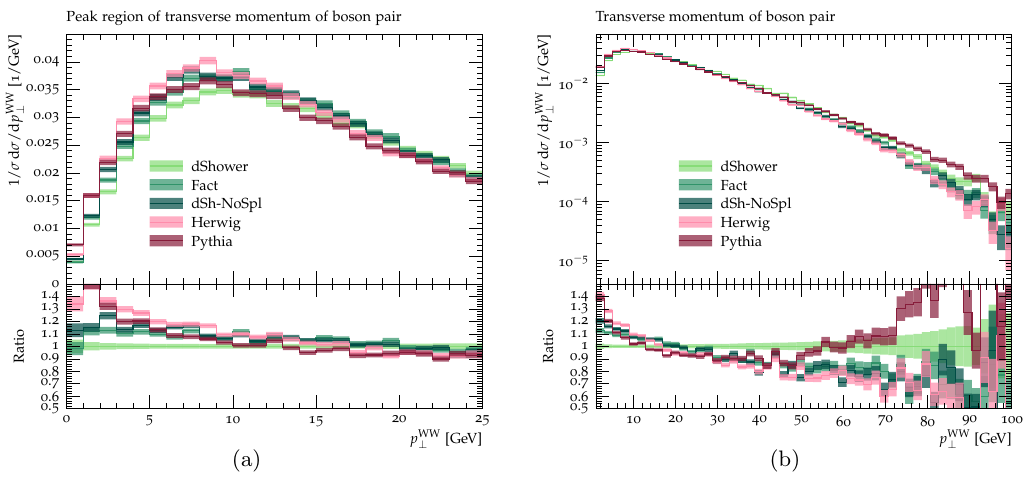
Figure 13 . (a) and (b) Transverse momentum of the WW pair. The setup dShower is the reference in the ratio